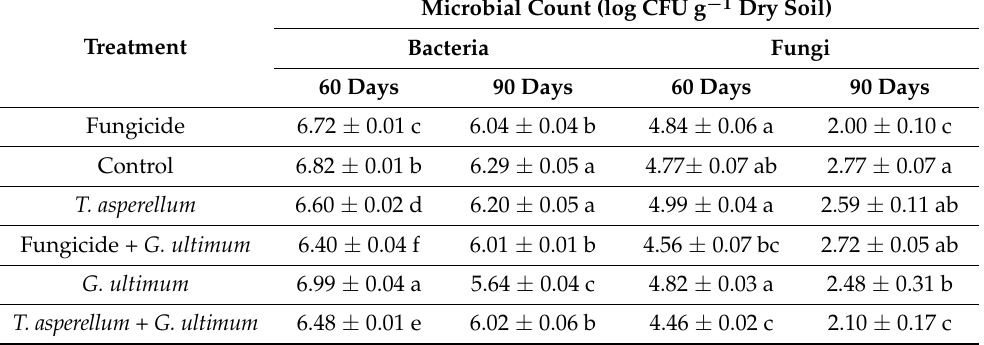
Table 8. Total bacterial and fungal count in the rhizosphere soil of pea plants after 60 and 90 days of